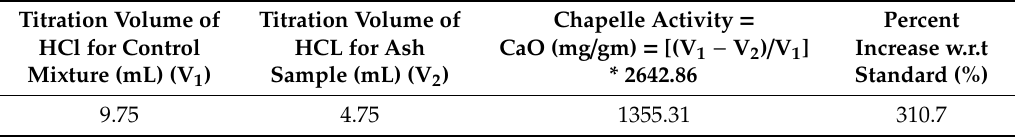
Table 5. Chapelle’s test results of sugar cane bagasse ash (SCBA).